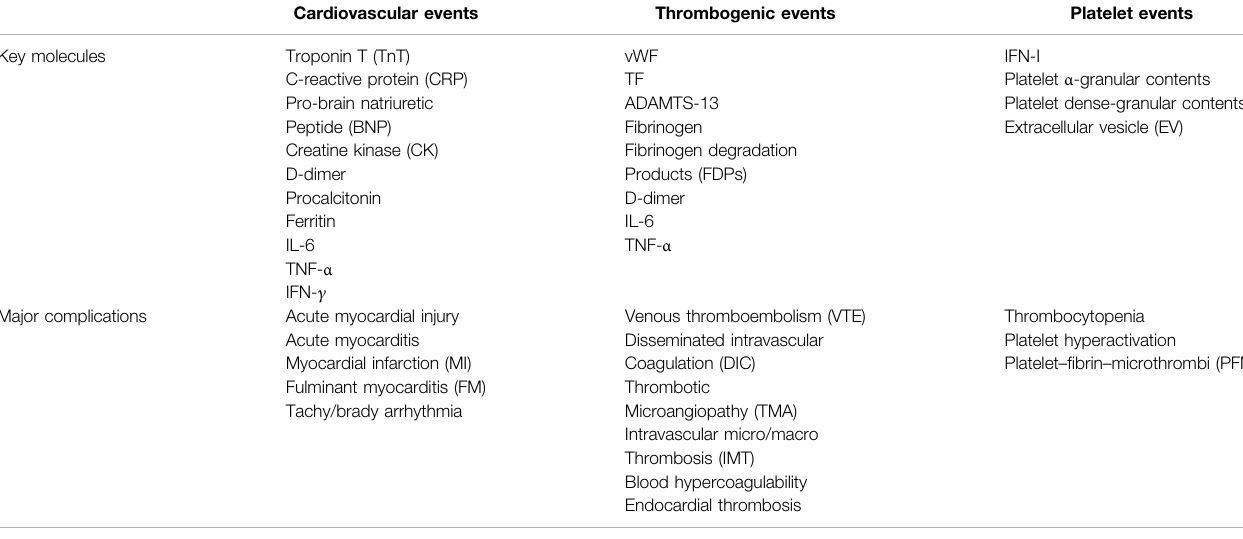
TABLE 1 | List of different key molecules and major complications due to cardiovascular, thrombogenic, and platelet impairments in COVID-19.